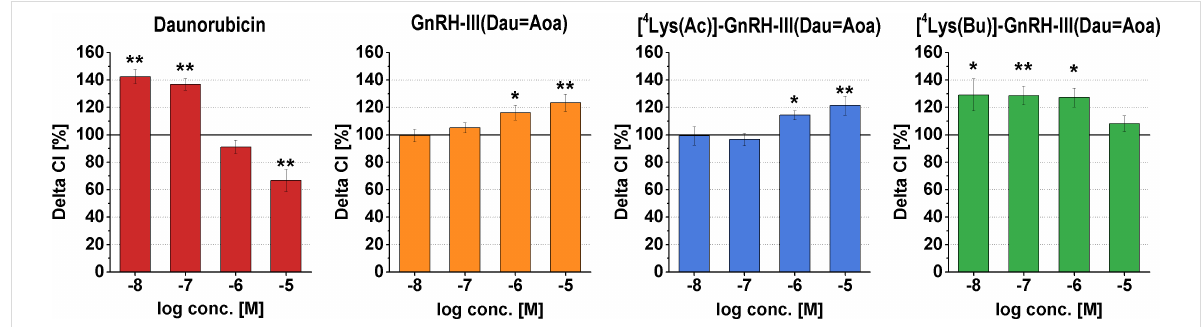
Figure 5: Effects of the conjugates and daunorubicin (Dau) on melanoma cell adhesion. The Delta CI (Delta Cell index) normalized to the control (control = 100%) refers to the difference of the Cell index value at the point in time of cell inoculation and the Cell index value at 3 h later. Data shown in the figures represent mathematical averages of three parallels and ± SD values. The levels of significance are shown as follows: *: p < 0.05; **: p < 0.01.